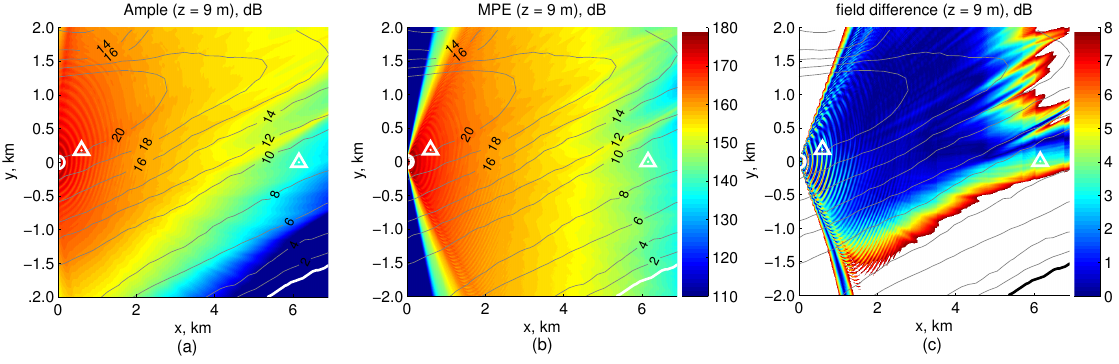
Figure 5. Spatial distribution of the SEL parameter at a horizon of 9 m, calculated by Ample ( a ) and MPE ( b ) for realistic bathymetry. Field difference module ( c ).